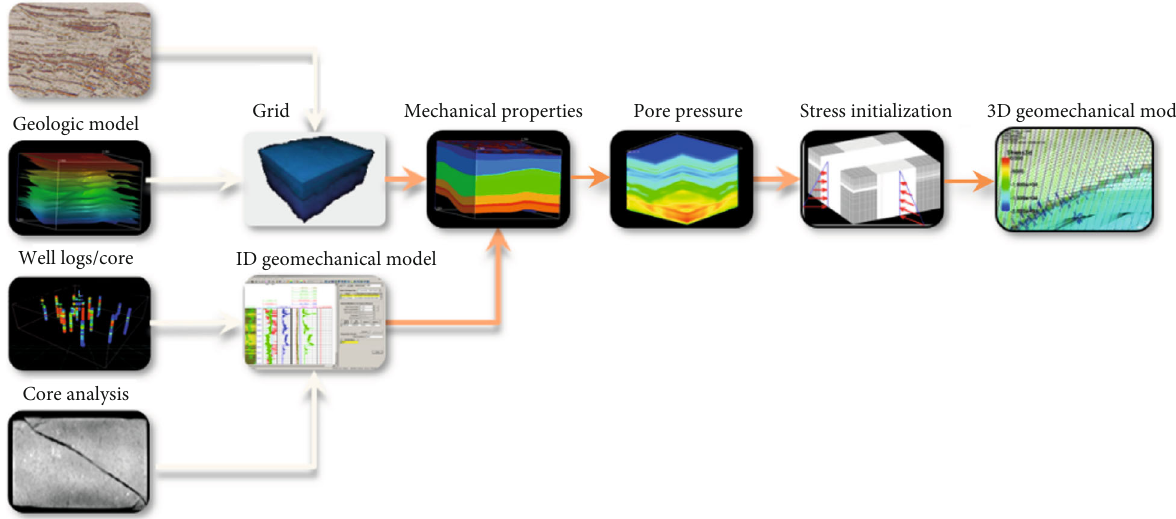
Figure 4: The modeling process to build the 3D geomechanical model.